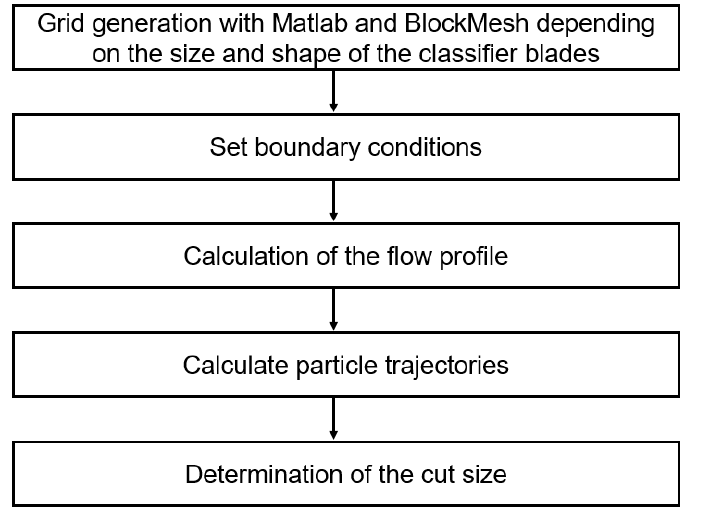
Figure 8. A flowchart for the cut size model.